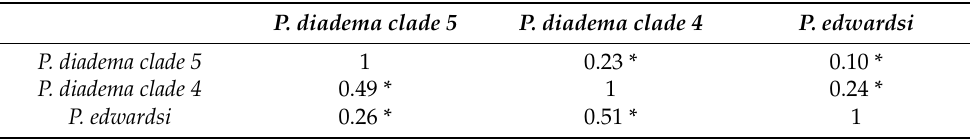
Table 3. Two metrics comparing the overlap between ecological niches for P. diadema and P. edwardsi . Schoener’s D is represented in the upper right triangle of the table and Hellinger’s I in the lower left. Both metrics range from 0 (no overlap) to 1 (identical). Pairs that were shown to be significantly different using the Identity Test are marked with an asterisk